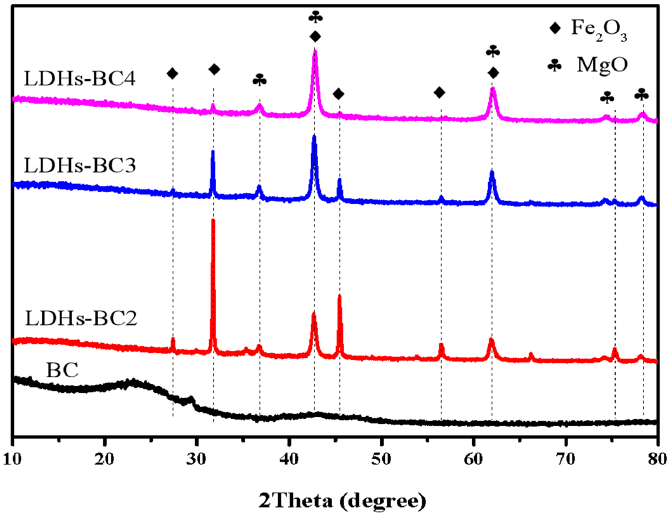
Figure 2. XRD patterns of BC, LDHs-BC2, LDHs-BC3, and LDHs-BC4.